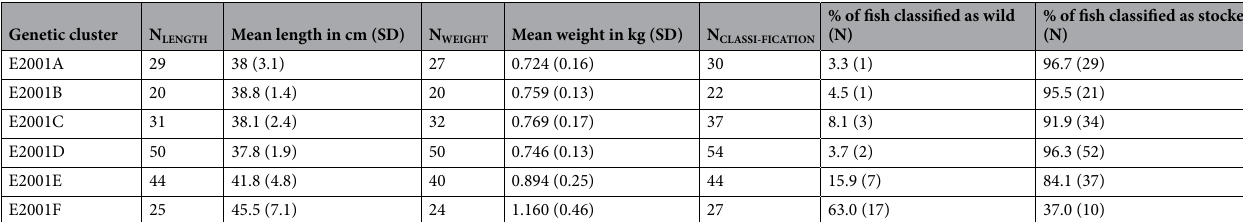
Table 2. Overview of length and weight data for the historical samples in zone E, sorted according to genetic subgroups E2001A–F. In addition, the morphological classification into wild and stocked fish based on fin damage is given in percent and total numbers. For each measurement or classification, the number of individuals is given (i.e., N LENGTH , N WEIGHT , N CLASSIFICATION